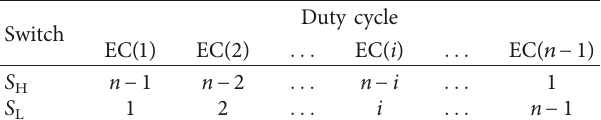
Figure 2: Equalization control circuit topology. Table 1: Duty cycle rate of equalization